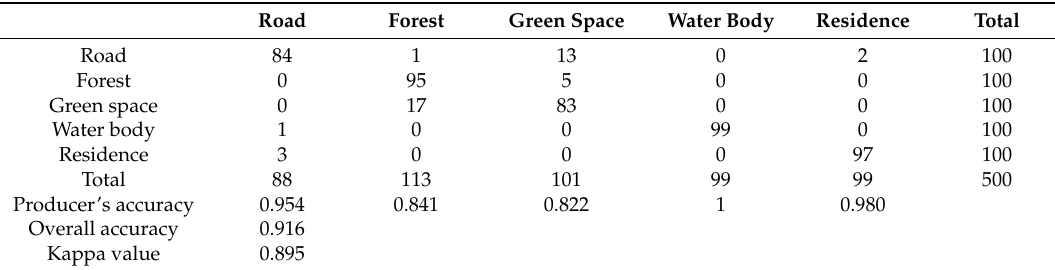
Table 4. The confusion matrix of the Best_CNN